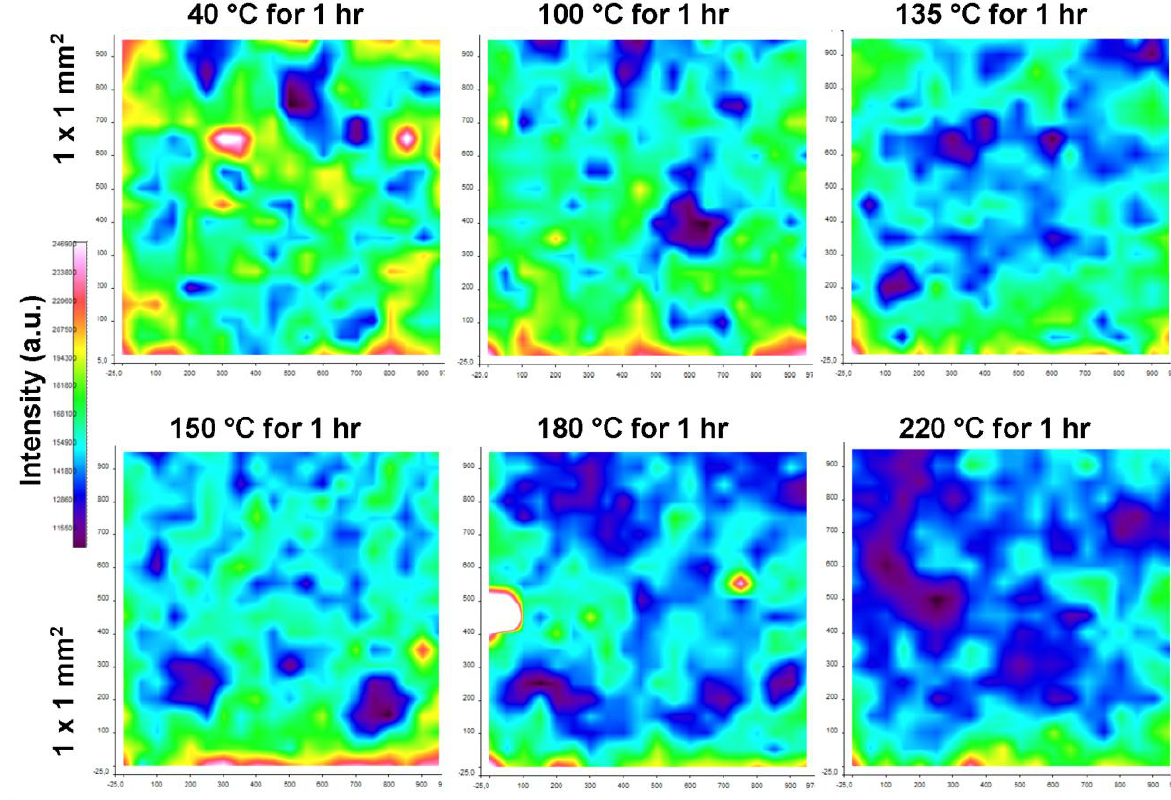
Figure 11. Raman chemical surface mapping for modified MFC films after curing at different temperatures for 1 h (X and Y-axis represent distances 0 to 1000 µm). Same intensity scale bar applies to all images, where, red = highest intensity; green = intermediate intensity; blue = lowest